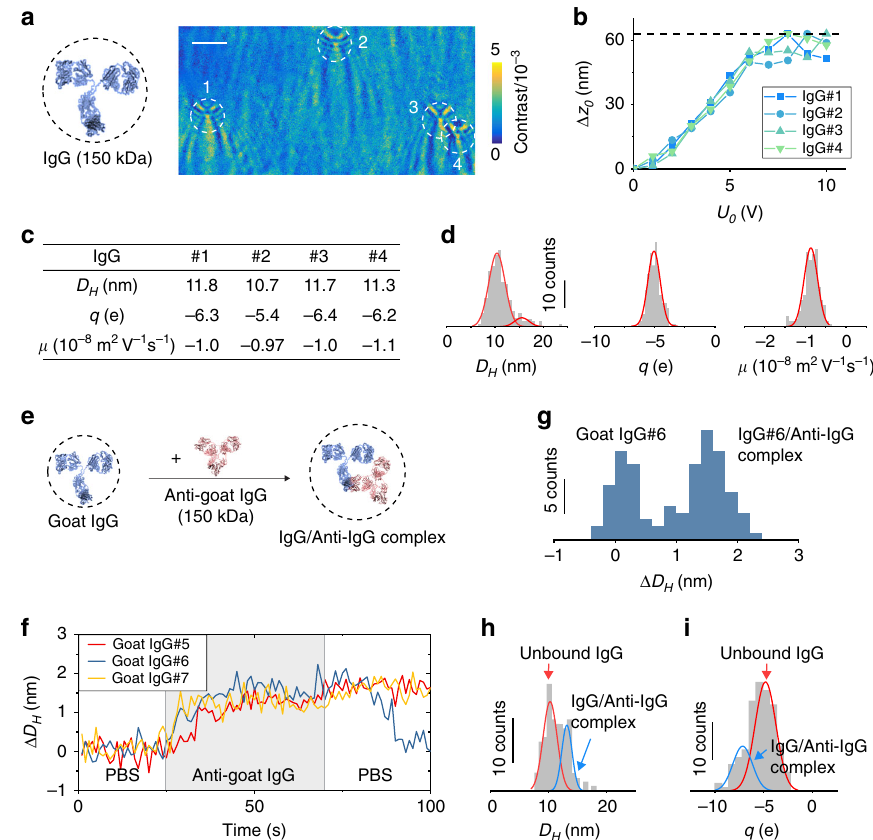
Fig. 2 Quantifying the size, charge, and mobility of single proteins. a FFT image of immunoglobulin G (IgG) measured with potential amplitude, U 0 = 8 V. Scale bar, 3 µ m. b Oscillation amplitude ( Δ z 0 ) vs. potential amplitude ( U 0 ) plots for the IgG molecules marked in a , from which diameter ( D H ), charge ( q ), and mobility ( µ ) are obtained. c Measured D H , q , and µ of the molecules shown in b . d Histograms of D H , q , and µ measured for 186 IgG molecules, where the red curves are Gaussian fi ttings (see Supplementary Table 4). e Anti-goat IgG is introduced to bind with goat IgG tethered on the surface. f Binding/ unbinding of anti-goat IgG with three goat IgG molecules tracked in real time, showing diameter changes associated with the binding and unbinding events. Potential amplitude: U 0 = 9 V. Buffer: 100× diluted PBS at pH = 7.4. Anti-goat IgG concentration:130 nM. g Size distribution of a goat IgG molecule (#6 shown in f ) measured during its binding/unbinding with anti-goat IgG, where the two peaks correspond to IgG and anti-IgG/IgG complex, respectively. h , i D H and q histograms of 137 goat IgG molecules obtained after incubation with 33 nM anti-goat IgG for ~30 min, where the two peaks are due to IgG and anti-IgG/IgG complex (see Supplementary Table 4 for the extracted mean D H and q ; Supplementary Fig. 4a for the mobility histogram). The blue and red lines are Gaussian fi ttings of the